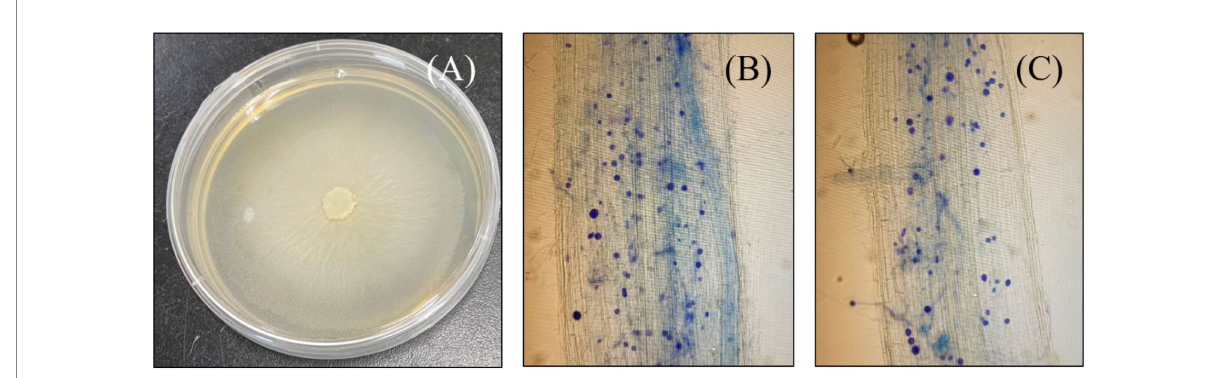
FIGURE 1 Photograph of a petri plate growing culture of Serendipita indica (A) , and microscopic images of both rice genotypes successfully colonized with S. indica spores; Roots of ZZY-1 genotype (B) and, GD-6 genotype (C)